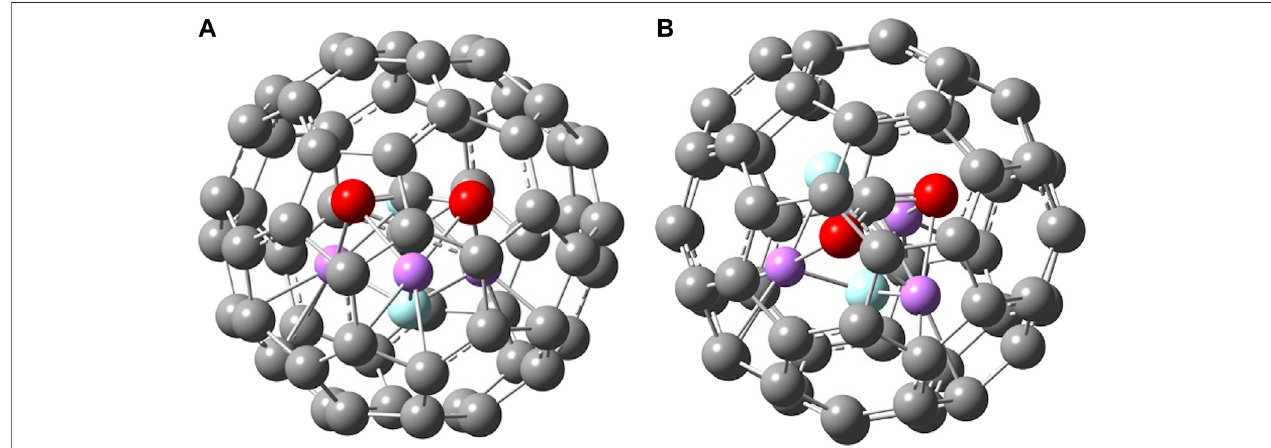
FIGURE 5 | Two different views of B3LYP/6-31G* optimized geometry of C 60 · Li 3 F 2 (D 3h ) · CO 2 .